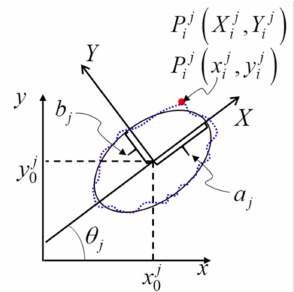
(cid:16) (cid:17) x j , y j in the image coordinate system xy . The broken 0 0